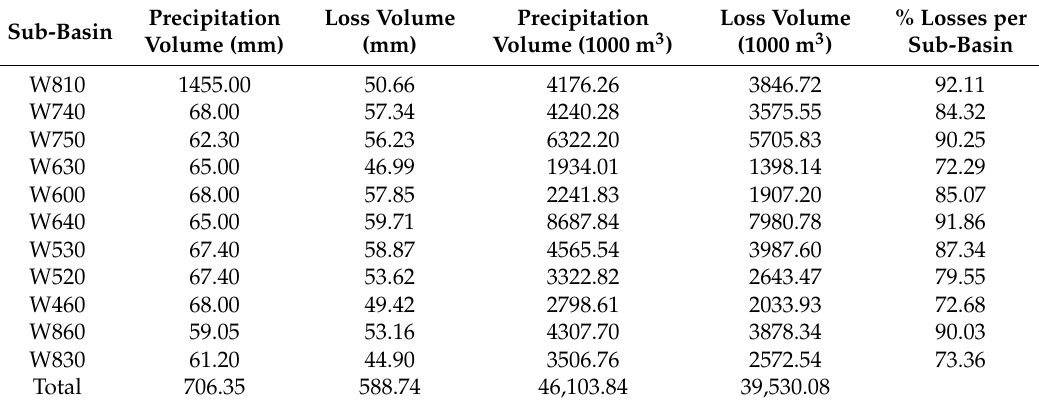
Table 14. Basin losses of 1996.